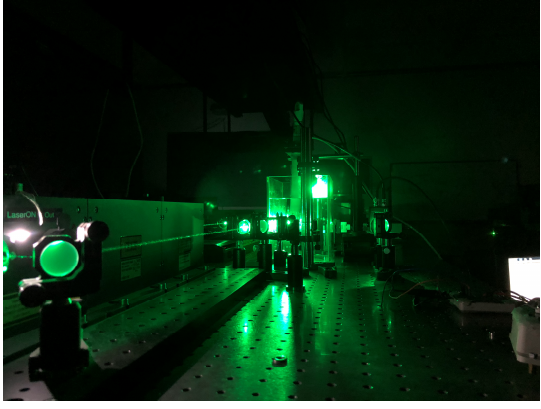
Figure 2. Experiment photography.